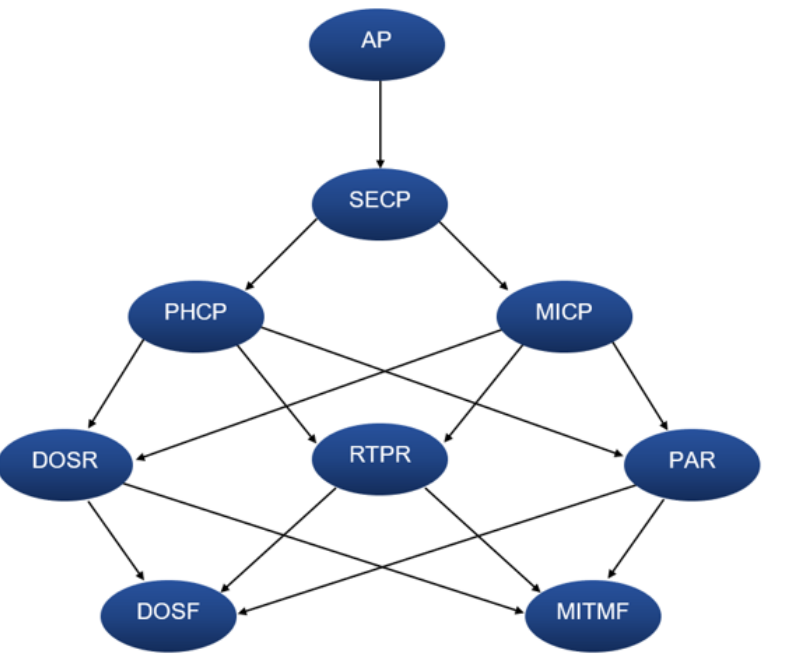
Figure 11. Simulated environment of smart home attacks.